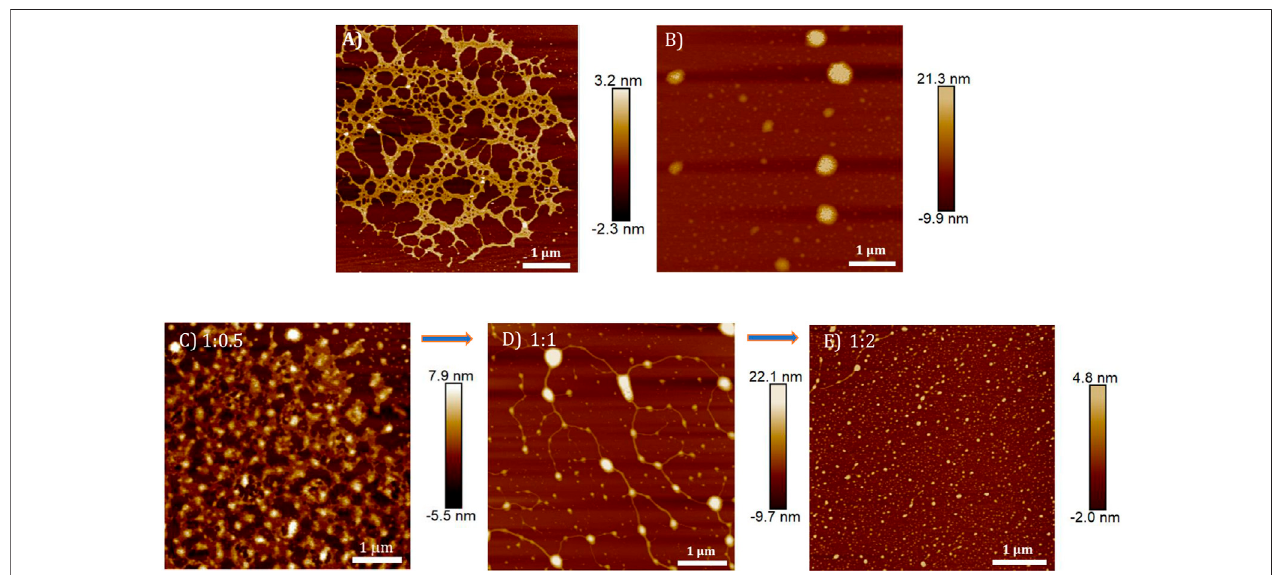
FIGURE4| AFMimagesof (A) CT-DNA(15 μ M), (B)TPE-V1 (15 μ M)and TPE-V1/CT-DNA complexatdifferentCT-DNAto TPE-V1 ratios, (C) 1:0.5, (D) 1:1and (E) 1:2.